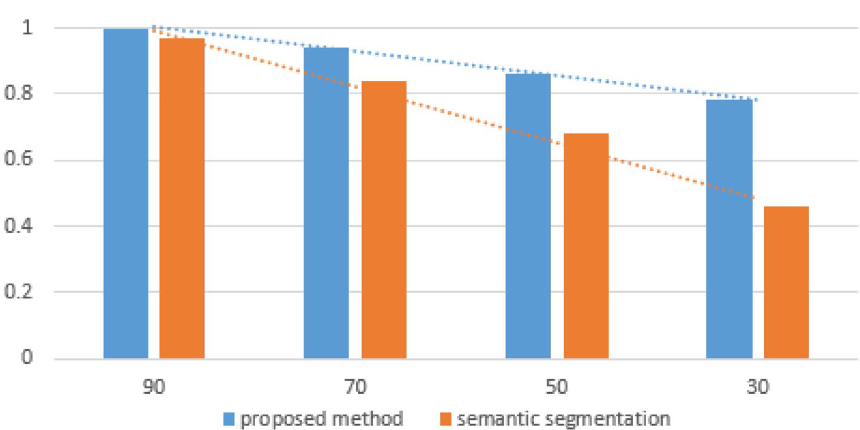
Figure 17. It is important to note that the CT object detection normalised accuracy for smaller datasets decreases significantly as the number of data decreases. For the proposed method, the trend line is less inclined.